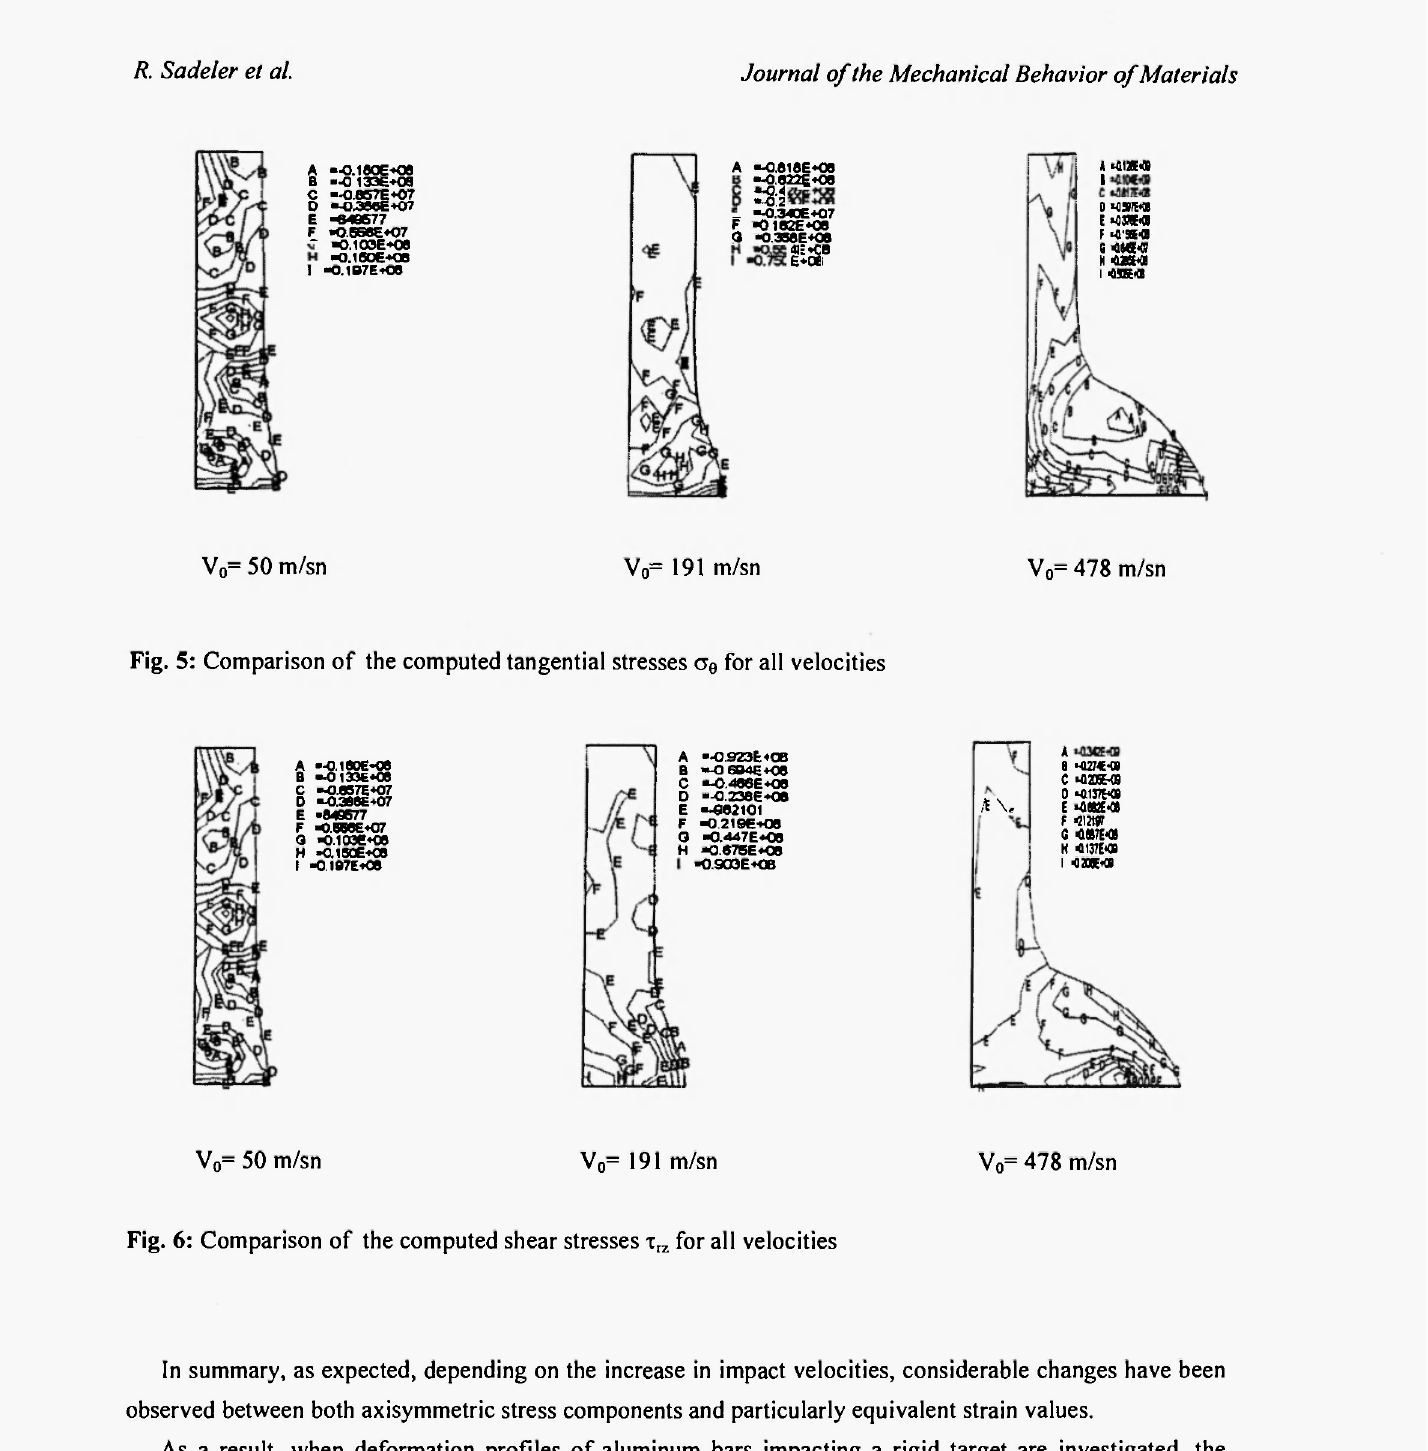
In summary, as expected, depending on the increase in impact velocities, considerable changes have been observed between both axisymmetric stress components and particularly equivalent strain values. As a result, when deformation profiles of aluminum bars impacting a rigid target are investigated, the lengths have decreased and the diameters have increased toward the sides due to the impact loading. These results are consistent with researches reported by Taylor and others (Lee and